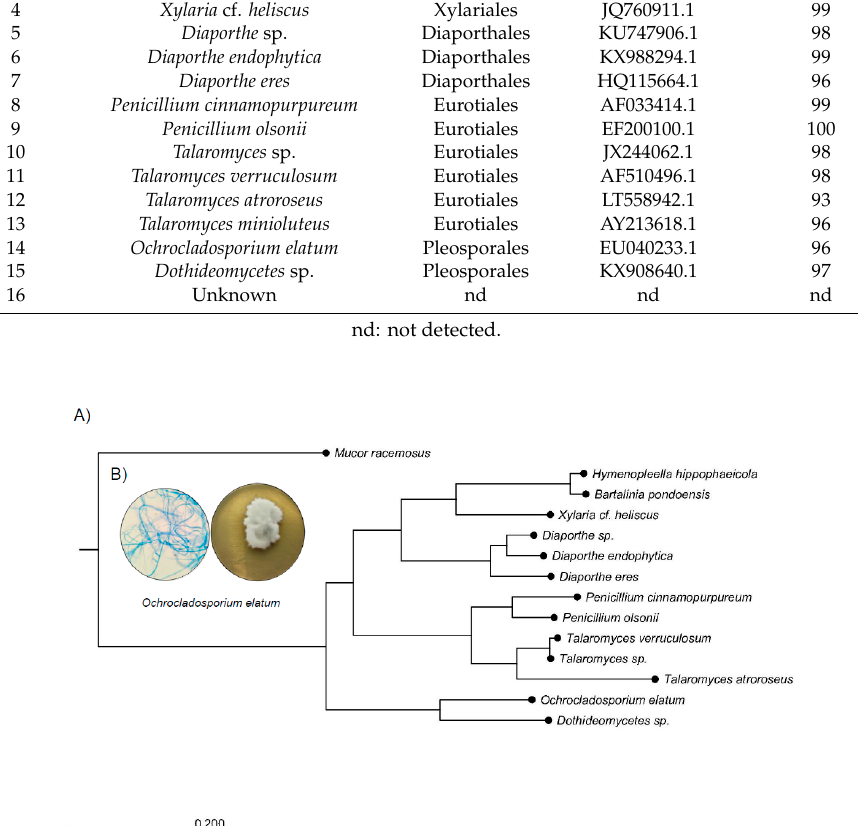
Table 1. Endophytic fungi isolated from S. terebinthifolius identified based on the BLASTed consensus sequence against the NCBI nucleotide database.